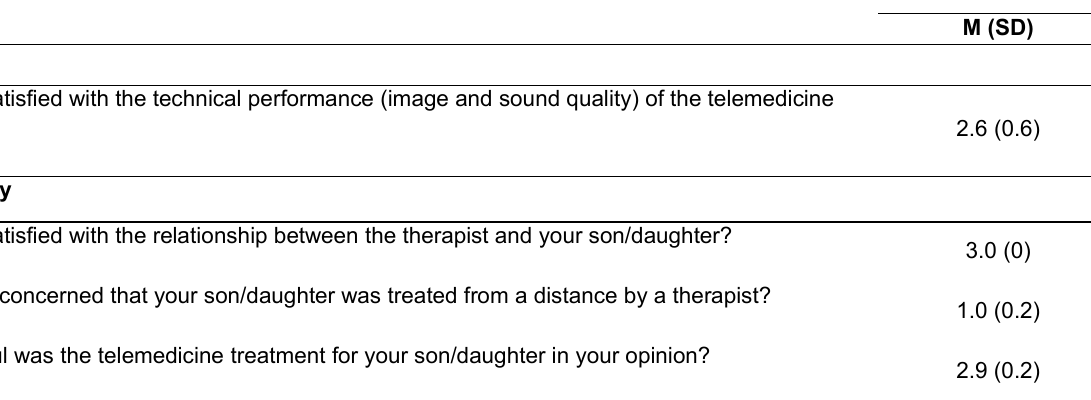
Items and Scores from the Parents’ Questionnaires Assessing Feasibility and Acceptability